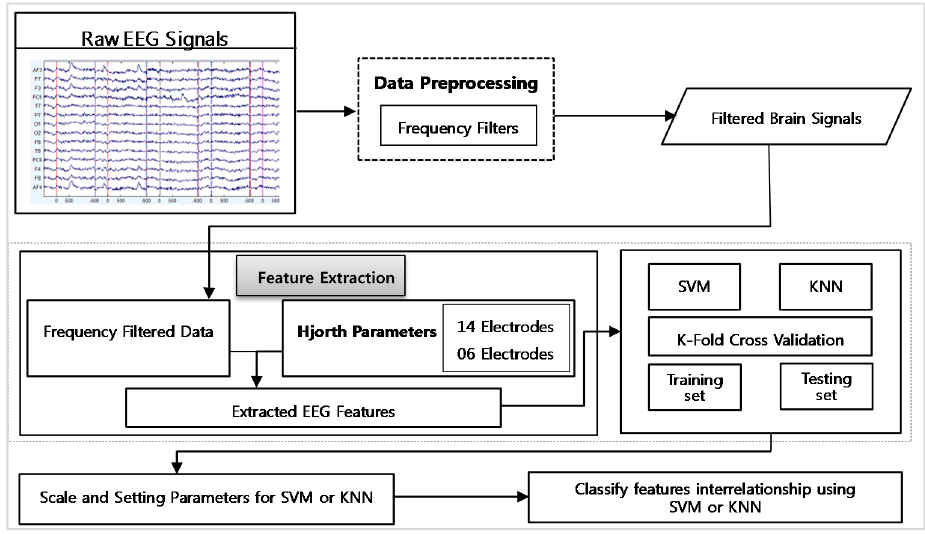
Figure 8. Emotion Recognition Module.